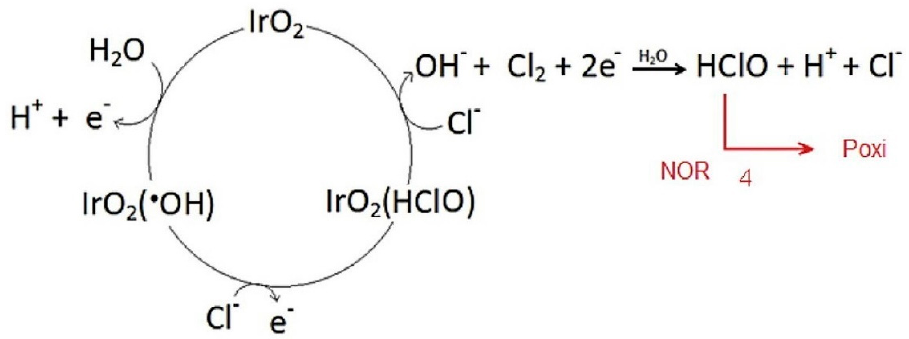
Figure 7. Main electrochemical degradation pathway of norfloxacin in presence of chloride ions. Reprinted with permission from ref. [87]. Copyright 2017 Elsevier.